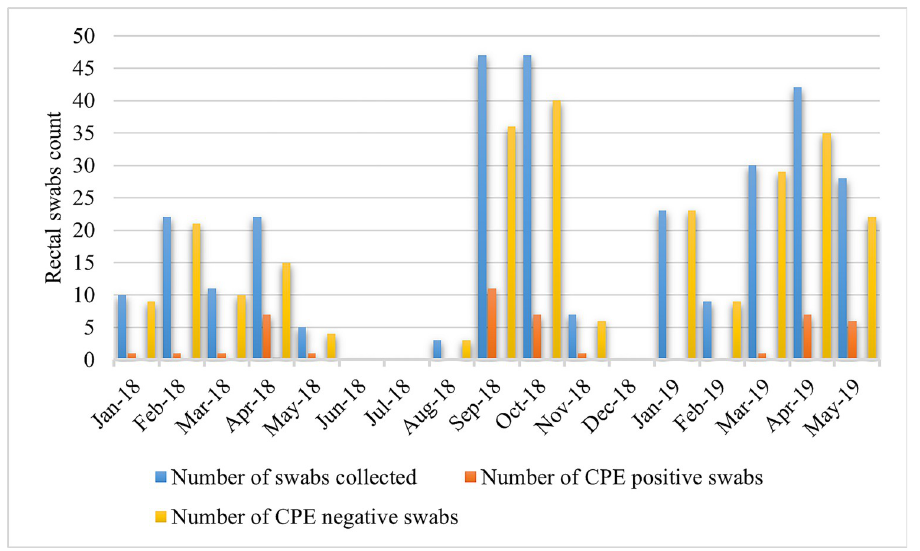
Fig 2. Distribution of CPE positive and negative samples by month of collection, (January 2018 to May 2019). with darker pink zone of precipitated bile salts, K . pneumoniae were mucoid, and pink. C .